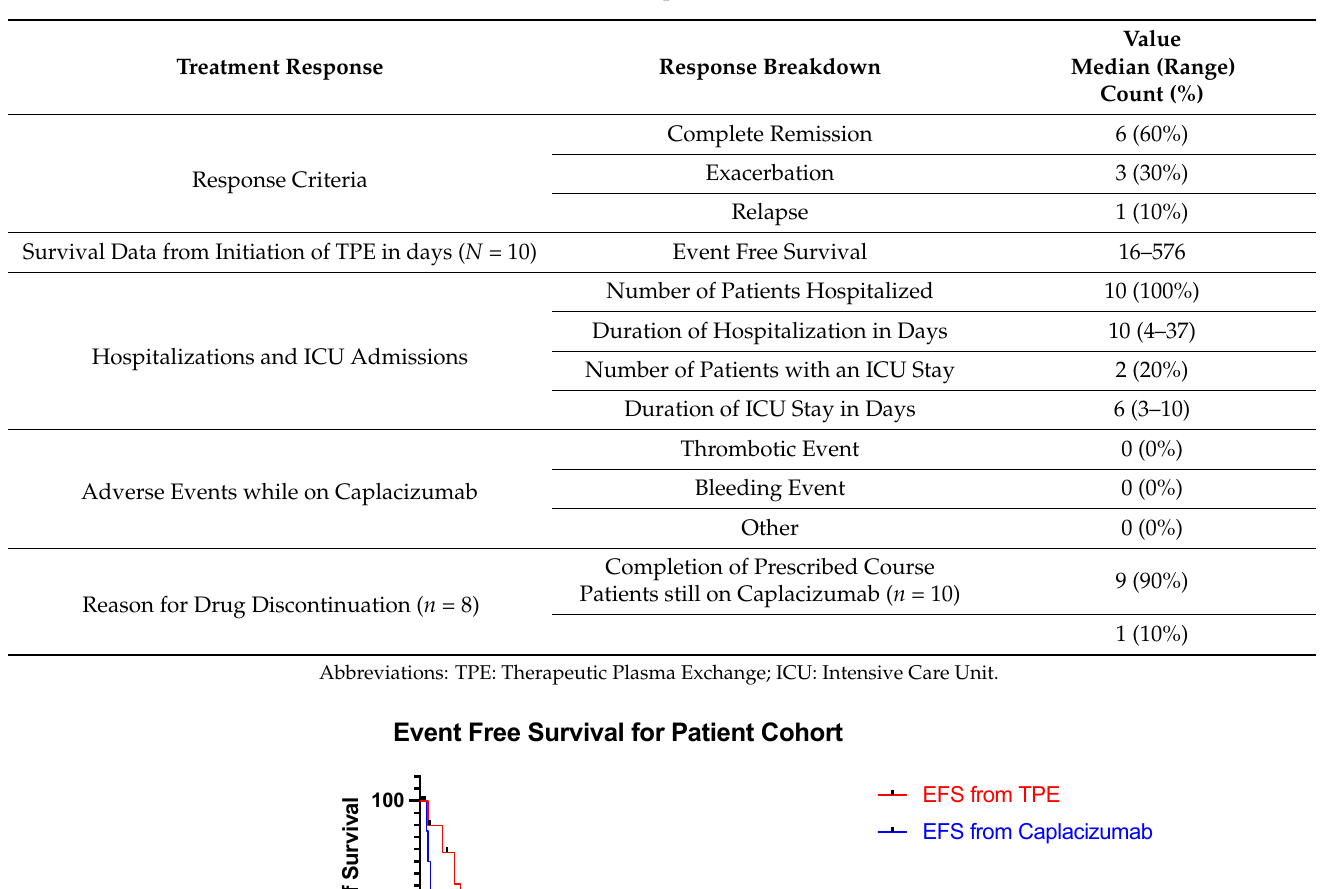
Table 3. Response Data.